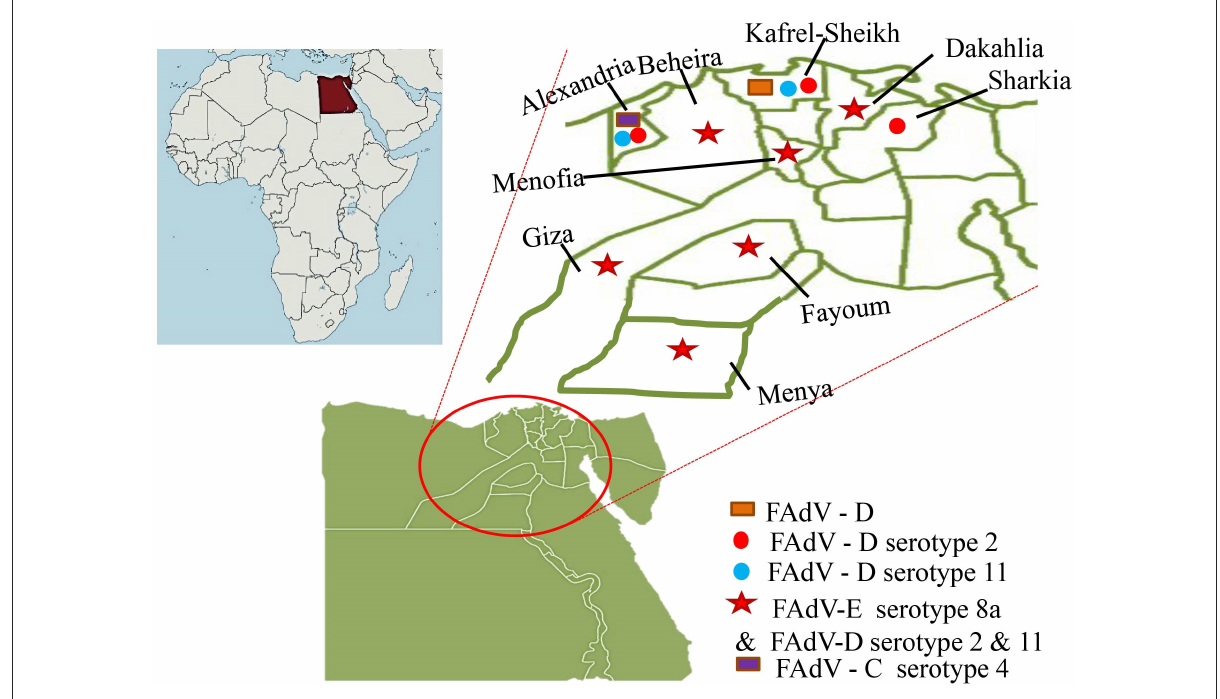
FIGURE2 The recorded distribution of fowl adenoviruses (FAdV) in